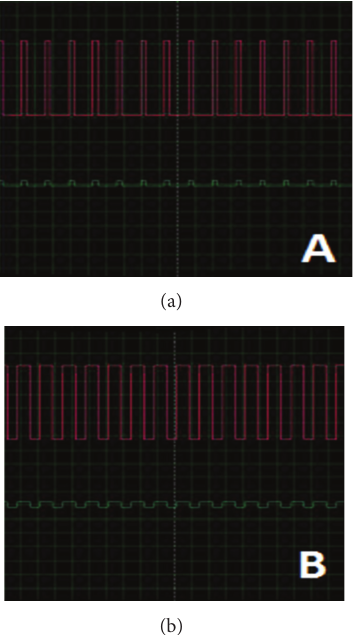
Figure 6: (a) Narrow ON time pulses (little vibration far distance), (b) wide ON time pulses (strong vibration close distance).